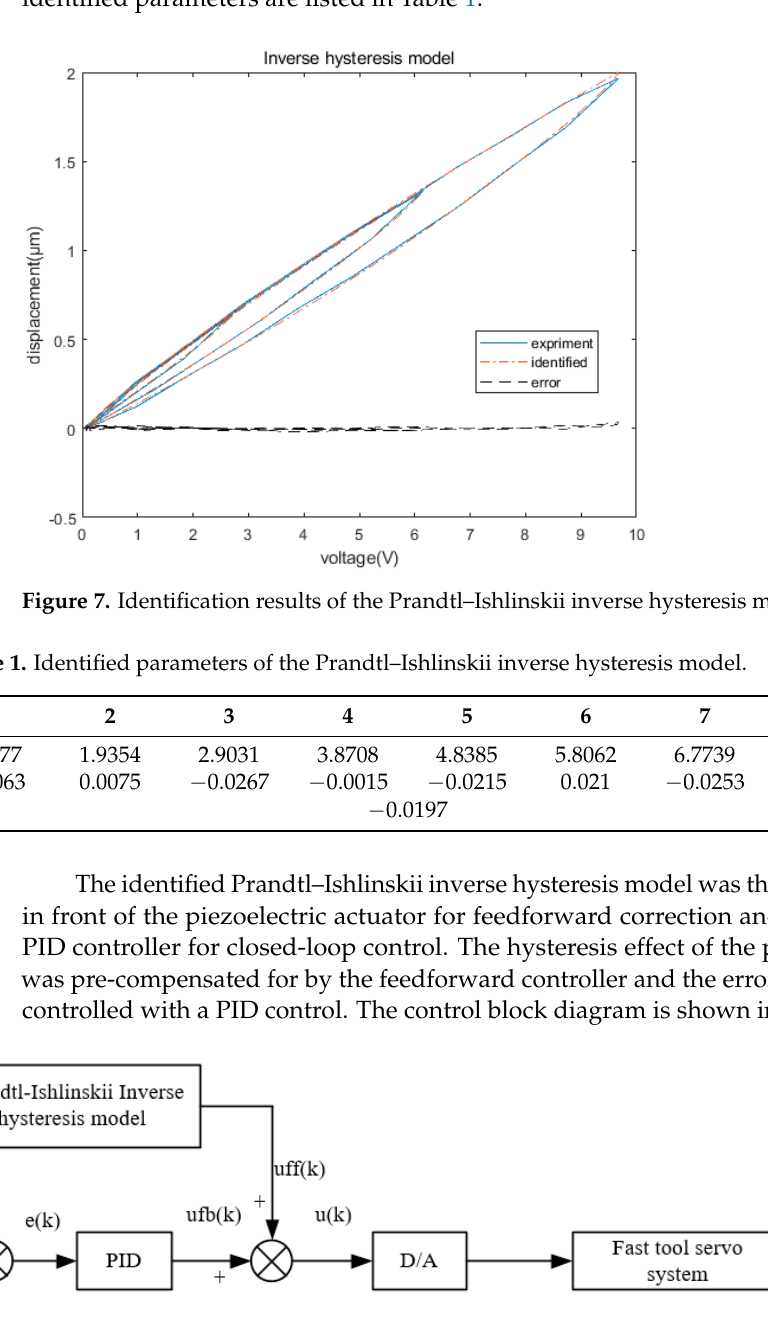
Figure 6. ( a ) Input voltage and output displacement; ( b ) experimentally obtained hysteresis curve. Identification results of the ( c ) traditional Prandtl–Ishlinskii model and ( d ) modified Prandtl–Ishlinskii model.